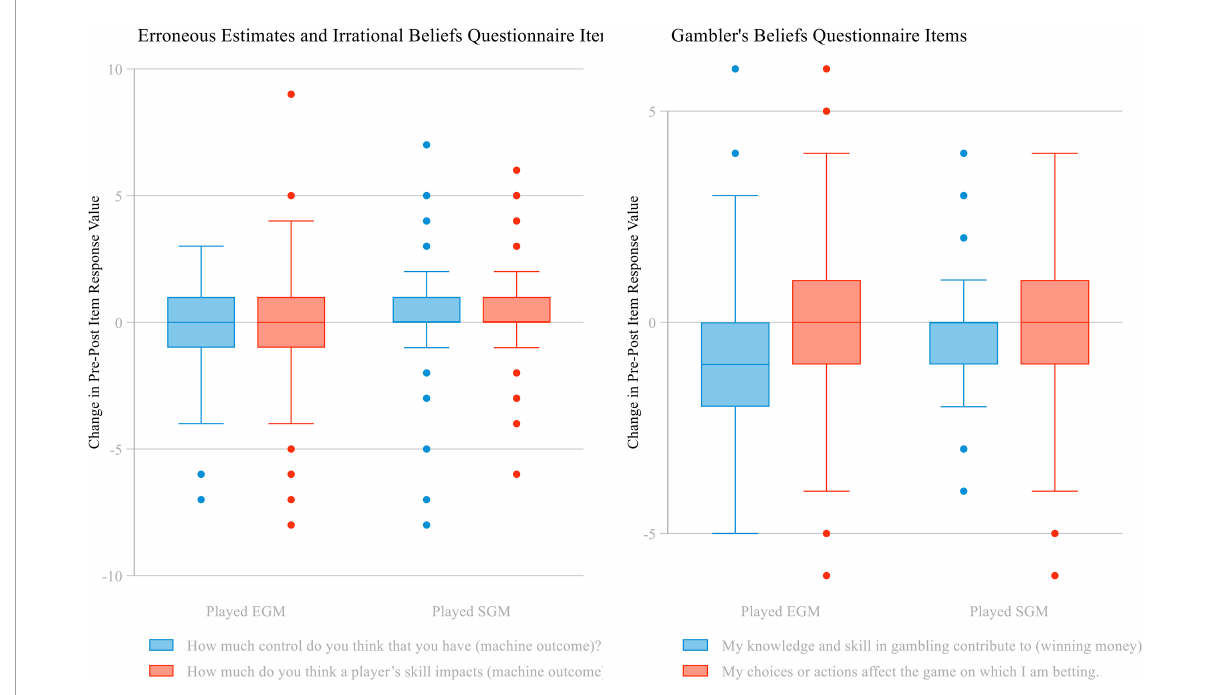
FIGURE2 Boxplot of t -test data regarding change in beliefs about the role of skill and control on electronic gaming machines.